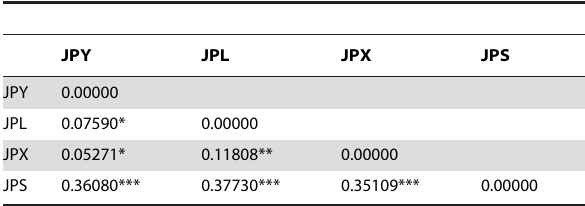
Table 5. Pairwise comparisons of genetic divergence estimates ( F ST ) between all host plants